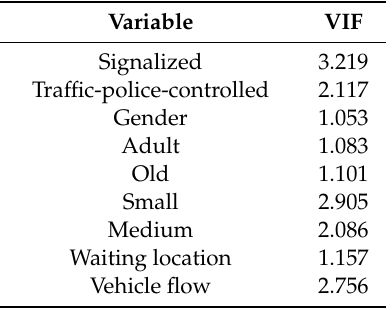
Figure A2. Scatter plot between the regression-standardized residual and the regression-standardized predicted value. Table A2. Multicollinearity (VIF) test